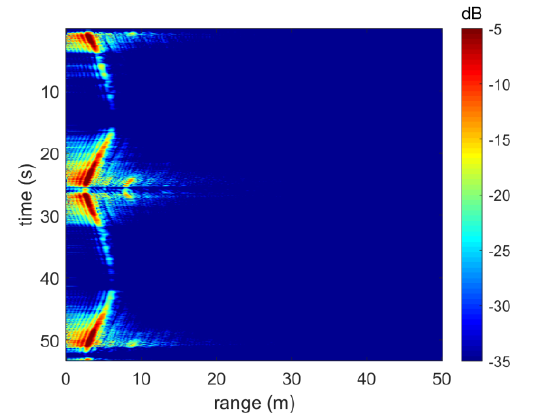
Figure 7. Range-Time image of moving target in front of the radar sensor after removing static targets as clutter